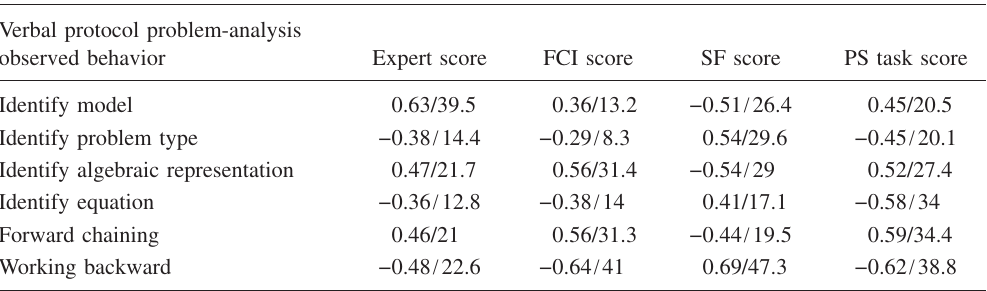
TABLE VI. Summary of correlation coefficient and R 2 values between post-tests and verbal protocol problem classification data. Categories that are statistically significant at p (cid:2) 0.05 are